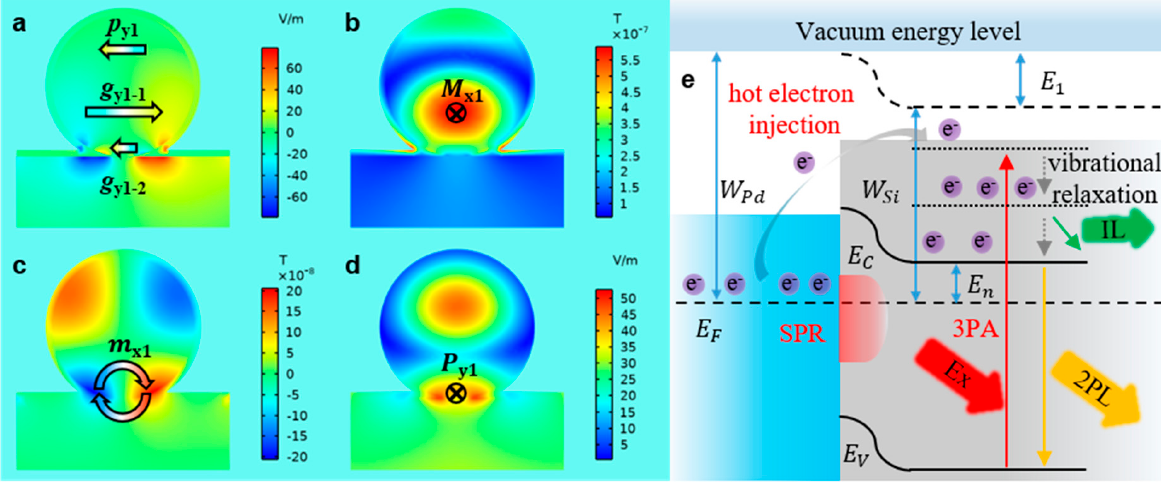
Figure 4. ( a − d ), the numerical near field distribution of the system ‐ 1 at 775 nm: the z component of the electric field distribution of the nanocavity ( a , YZ); the total magnetic field distribution of the nanocavity ( b , YZ); the z component of the magnetic field distribution of the nanocavity ( c , XZ); the total electric field distribution of the nanocavity ( d , XZ). ( e ), the energy level of the system ‐ 1.